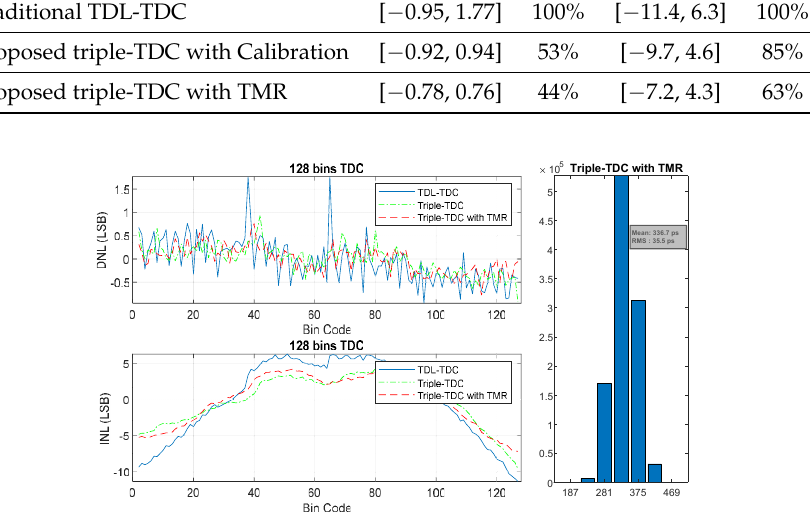
Figure 9. Measured INL, DNL, and RMS values for the proposed triple-TDC with